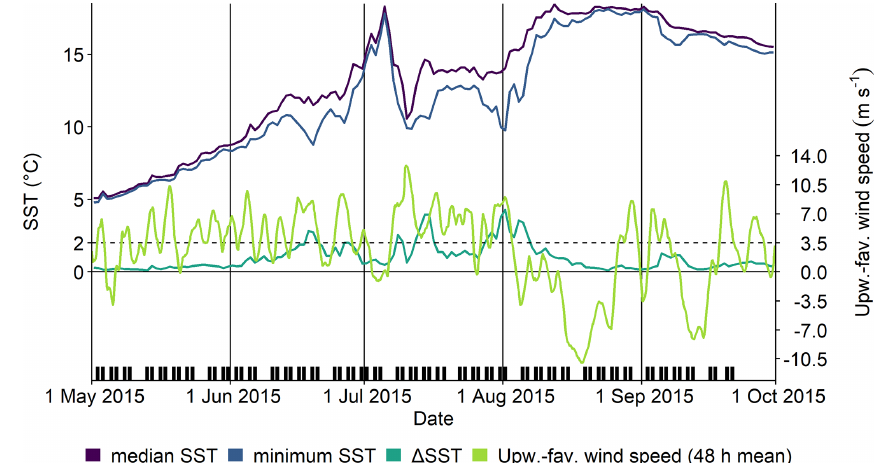
Figure A4. As Fig. 4 but within the Ö-S box in 2015 (here, both routes go through the box). Quasi-persistent upwelling-favourable wind conditions until the beginning of August effectively prohibited strong thermal stratification of the surface water. This results in lower possible SST gradients from upwelling and, therefore, a rather unreliable (cid:49) SST criterion, which is only triggered during the most intense periods. Please refer to Sect. 3.4 for a detailed discussion of this